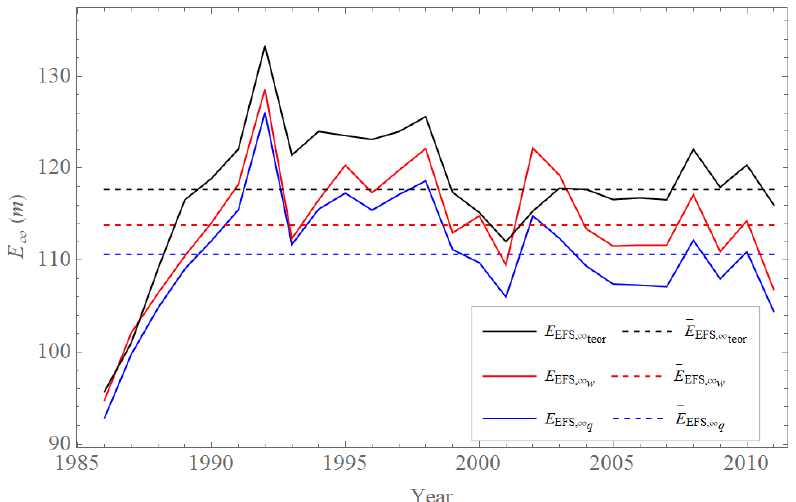
Figure 8. Values of limit (saturated) values E EFS , ∞ of the extended power law λ w (E) (red), E EFS , ∞ of the extended quadratic model w q λ q (E) (blue), and theoretical value E EFS , ∞ determined by Bednáˇr et al. (2021) (black) approximated from annual averages of the error teor growth rate λ EFS (E) of the ECMWF forecasting system’s 500hPa geopotential height values (Northern Hemisphere, 20–90 ◦ ) calculated as = 114 ± 7m differences between two operational forecasts issued with 1d lag but valid on the same day. The average value of E EFS , ∞ w = 111 ± 7m (blue, dashed), and E = 118 ± 7m (black, dashed). (red, dashed), E EFS , ∞ EFS , ∞ teor q